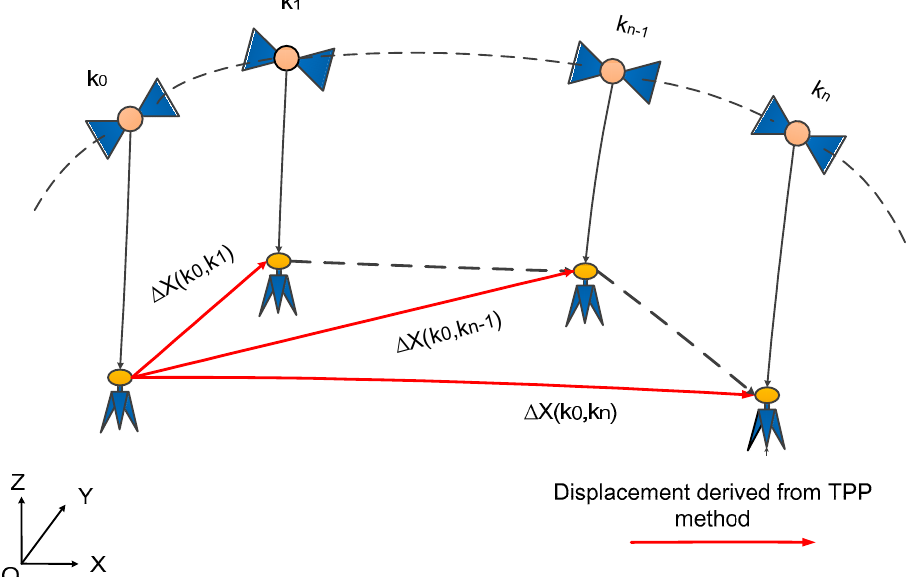
Figure 2. The sketch of real-time displacement retrieval method with real-time precise orbits and clocks.